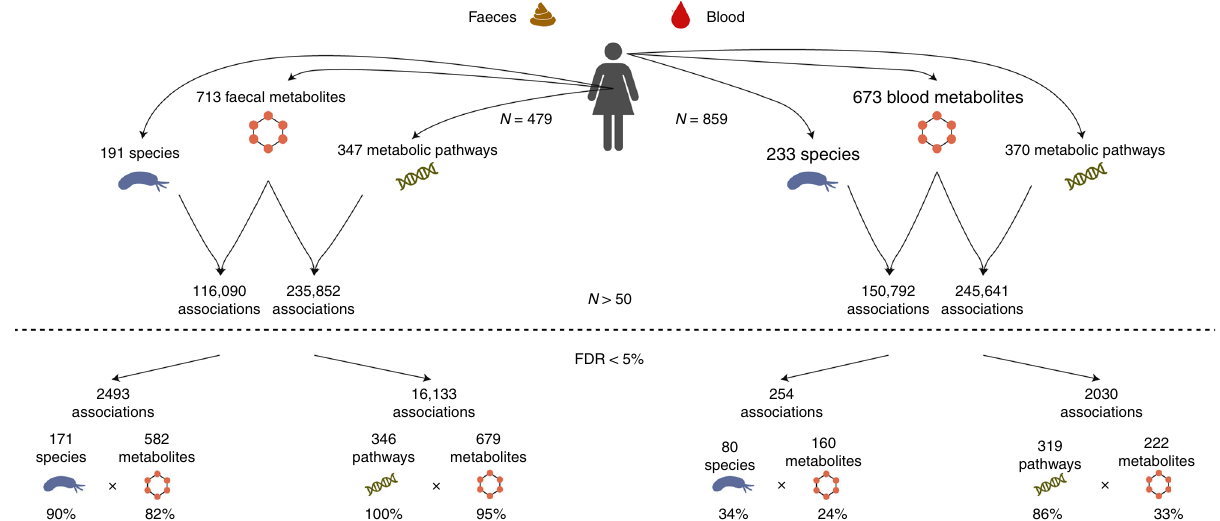
Fig. 2 Study design and number of associations. The top of the fi gure reports the number of microbial species and metabolic pathways which were detected in at least 50 individuals with metabolomics and WMGS data, and that were used in the study, and the number of associations tested. The bottom of the fi gure reports the number of associations that were signi fi cant at a 5% FDR, along with the number and percentage of metabolites, microbial species, and microbial metabolic pathways involved. Association testing was performed using PopPAnTe 12 , in order to model the resemblance between family members. Sex and age at the sample collection were included as